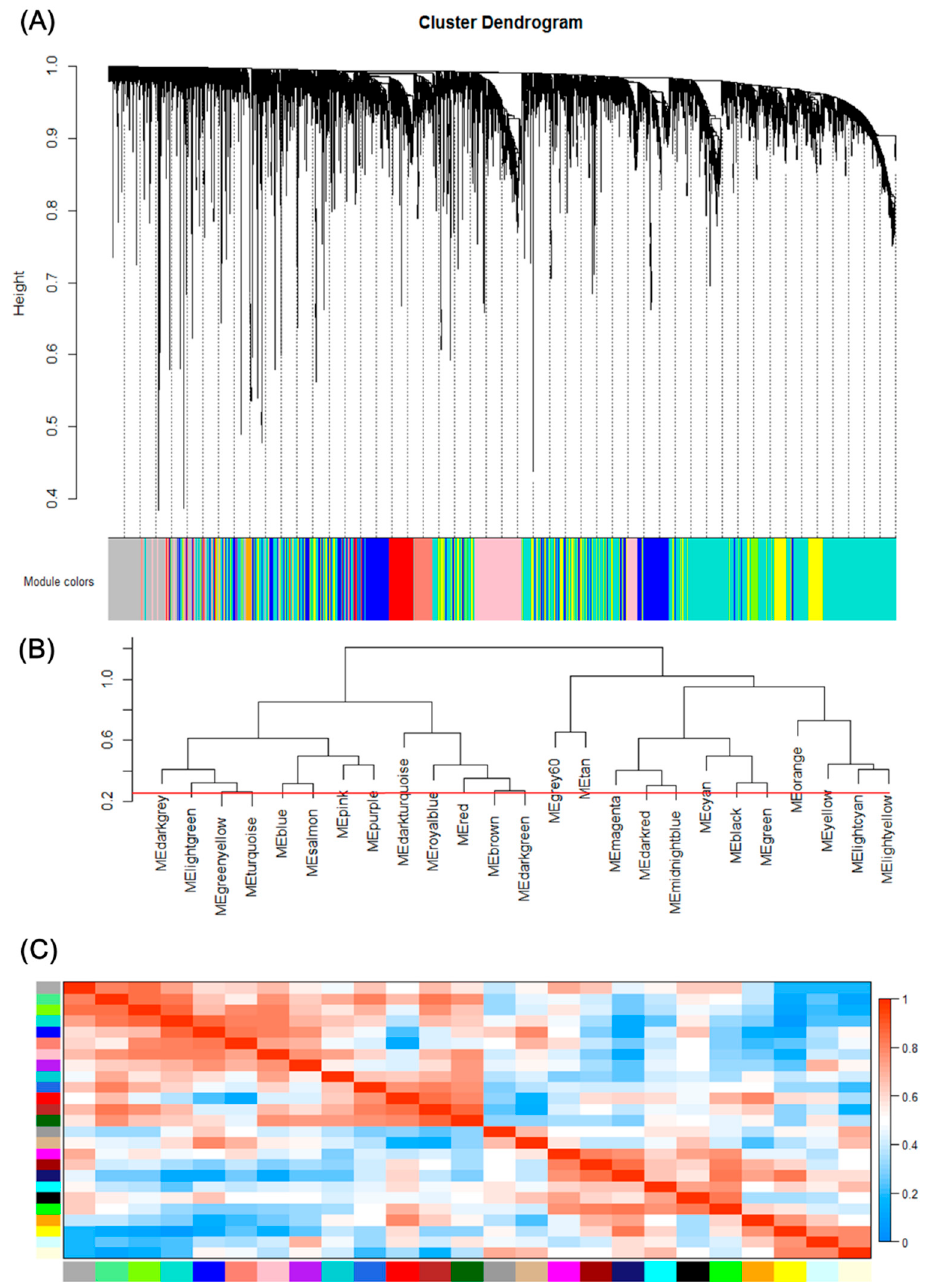
Figure 2. Gene modules identified by Weighted gene co-expression network analysis (WGCNA). ( A ) Gene dendrogram obtained by clustering the dissimilarity based on consensus Topological Overlap with the corresponding module colors indicated by the color row. Each colored row represents a color-coded module which contains a group of highly connected genes. A total of 25 modules were identified. ( B ) Dendrogram of consensus module eigengenes obtained by WGCNA on the consensus correlation. The red line is the merging threshold, and groups of eigengenes below the threshold represent modules whose expressions profiles should be merged due to their similarity. ( C ) Heatmap plot of the adjacencies of modules. Red represents high adjacency (positive correlation) and blue represents low adjacency (negative correlation).